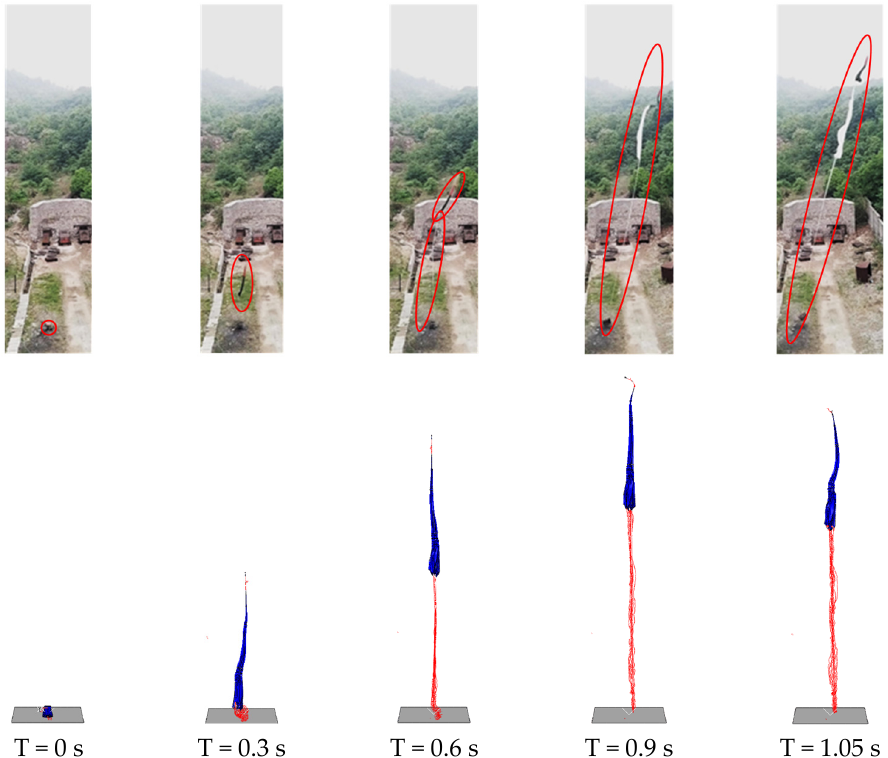
Figure 14. Comparison of deployment configuration between simulation and experiment.